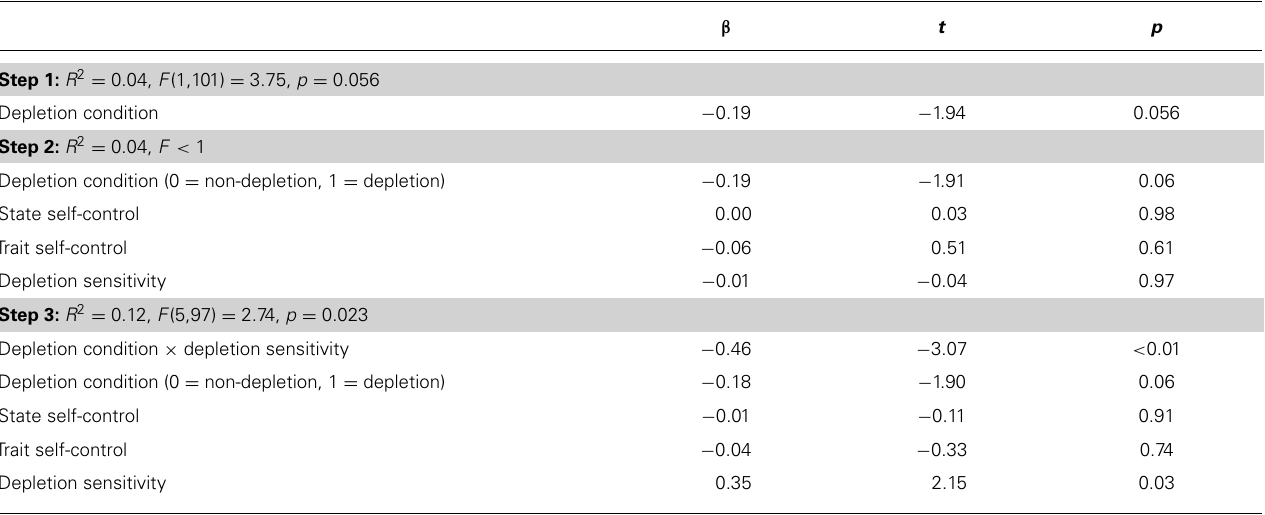
Table 5 | Regression analysis of cognitive task performance, Study 3.